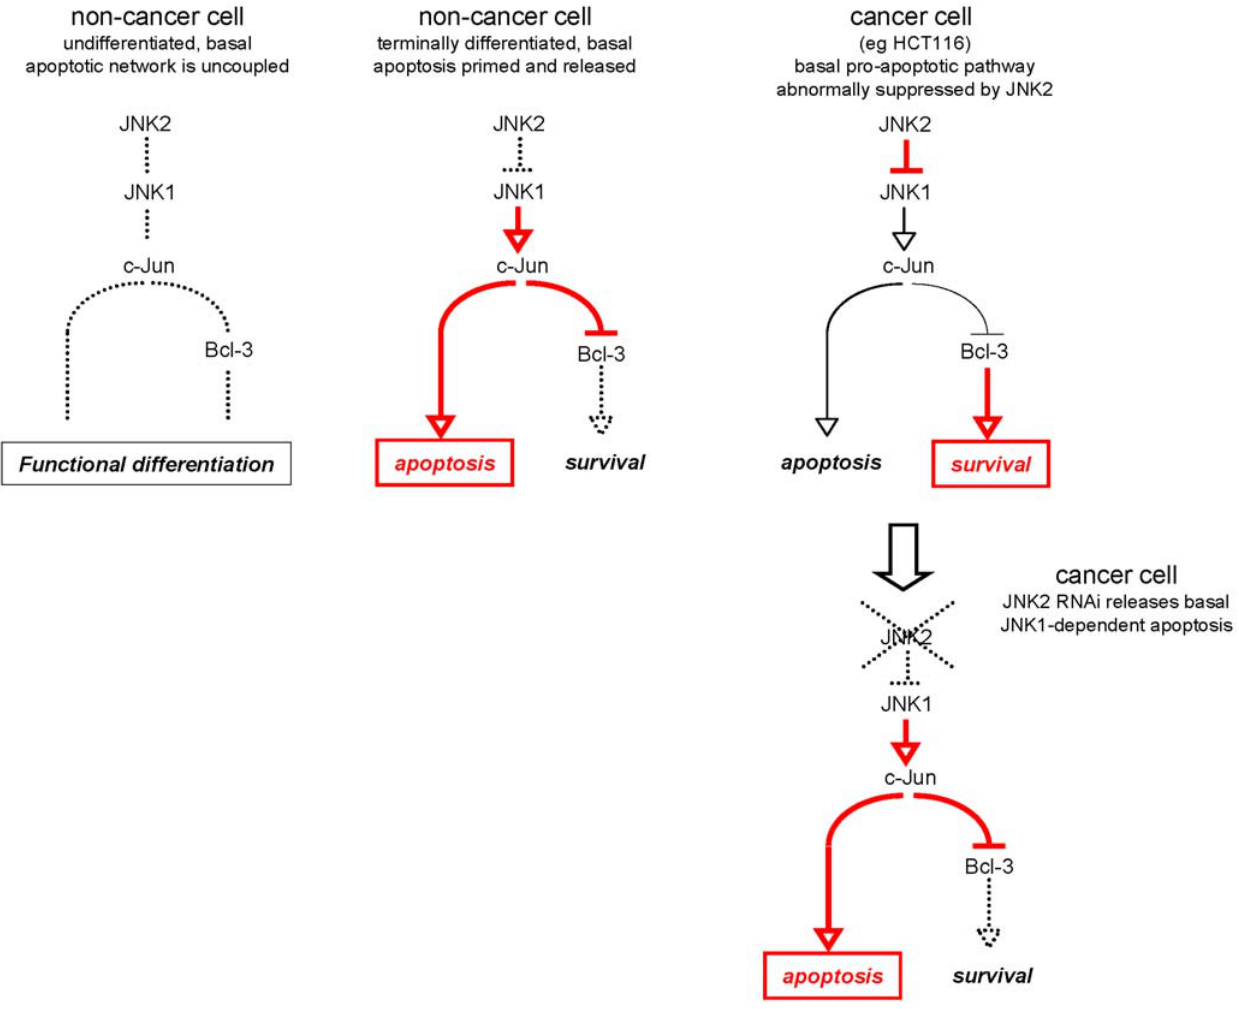
Figure 10. Basal regulation of apoptosis involves a novel network regulated by JNK2 and mediated via JNK1, c-Jun and Bcl-3. Hypothetical model for acquisition of an intrinsic apoptotic network in intestinal epithelial cells as they approach terminal differentiation. This network is subject to JNK2 which, abnormally, can enable cell survival and cancer via constitutive suppression of down-stream pro-apoptotic mediators under JNK1 control (see Discussion and Fig.